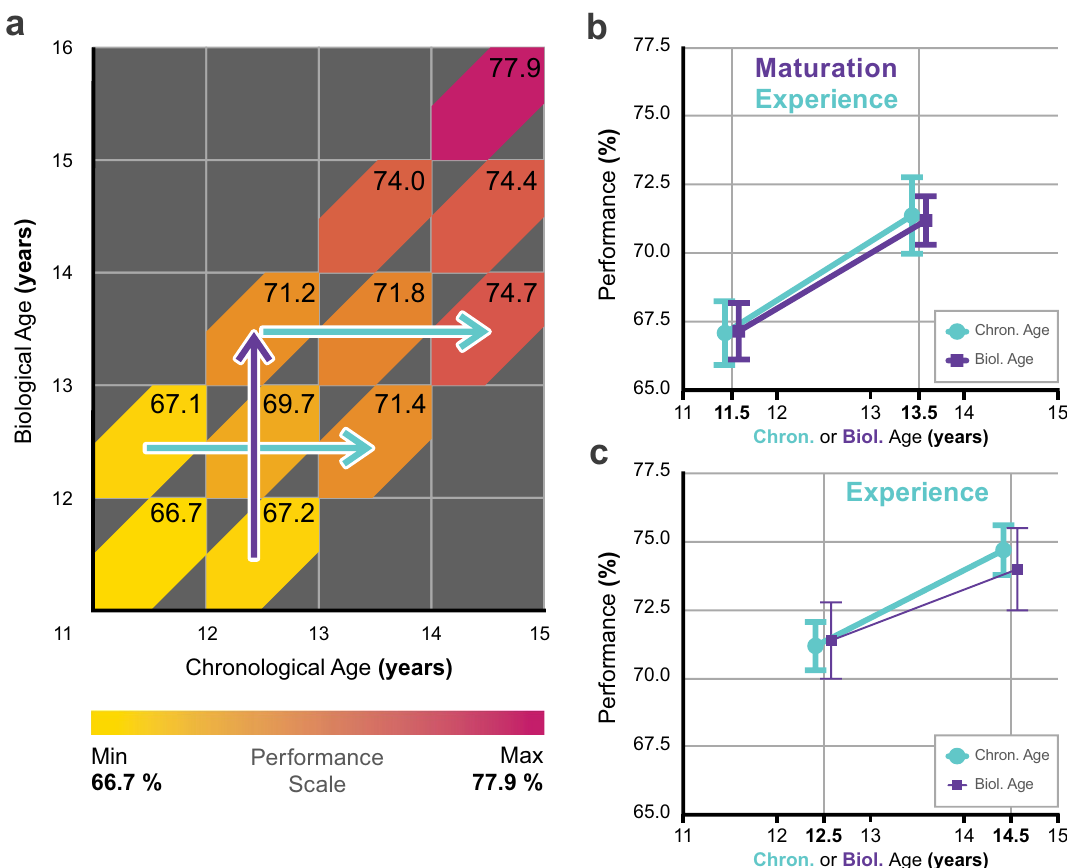
Figure 2. WISC-IV overall performance as a function of biological and chronological age. ( a ) Average WISC-IV overall performance (based on raw scores) was calculated for each bin as a % of possible maximum performance described in Fig. 1b and expressed on a colour scale (Performance scale). Higher performance is indicated by darker shades of red. Numbers within each coloured bin express performance in % of possible maximum performance. Purple arrow indicates bins where a significant biological age effect is present. Blue arrow indicates bins where a significant chronological age effect is present. ( b ) Detailed performance within the 11–14 years age-range where significant BA and CA effects according to one-way ANOVA are present (significant developmental changes are represented by bold lines). Both experience and maturation significantly determine performance. c Detailed performance within the 12–15 years age-range where significant chronological age-effect is present. Performance is determined by experience. Error bars show 1SE. The final version of the figure was generated by Adobe Illustrator CC 23.02.2